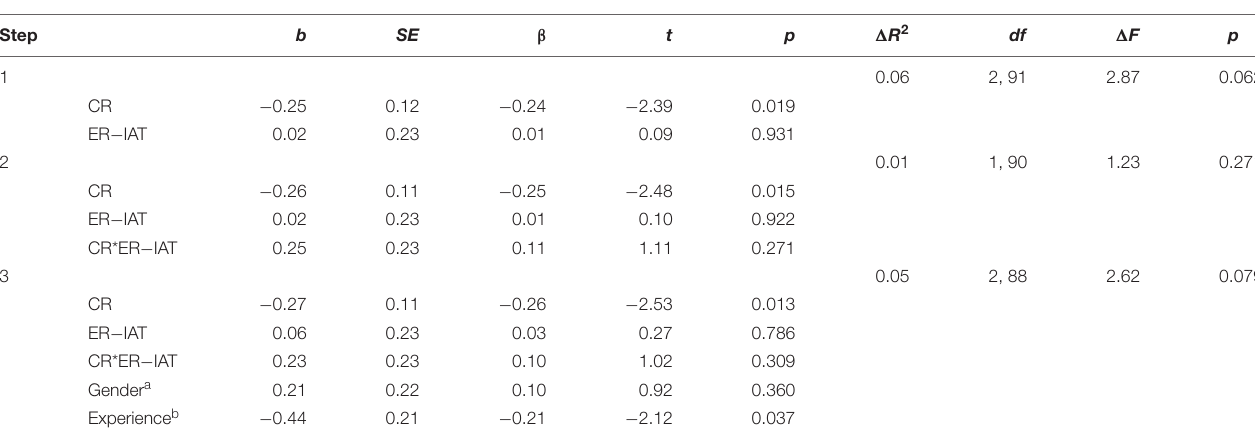
TABLE 6 | Results of the hierarchical multiple regression for Model